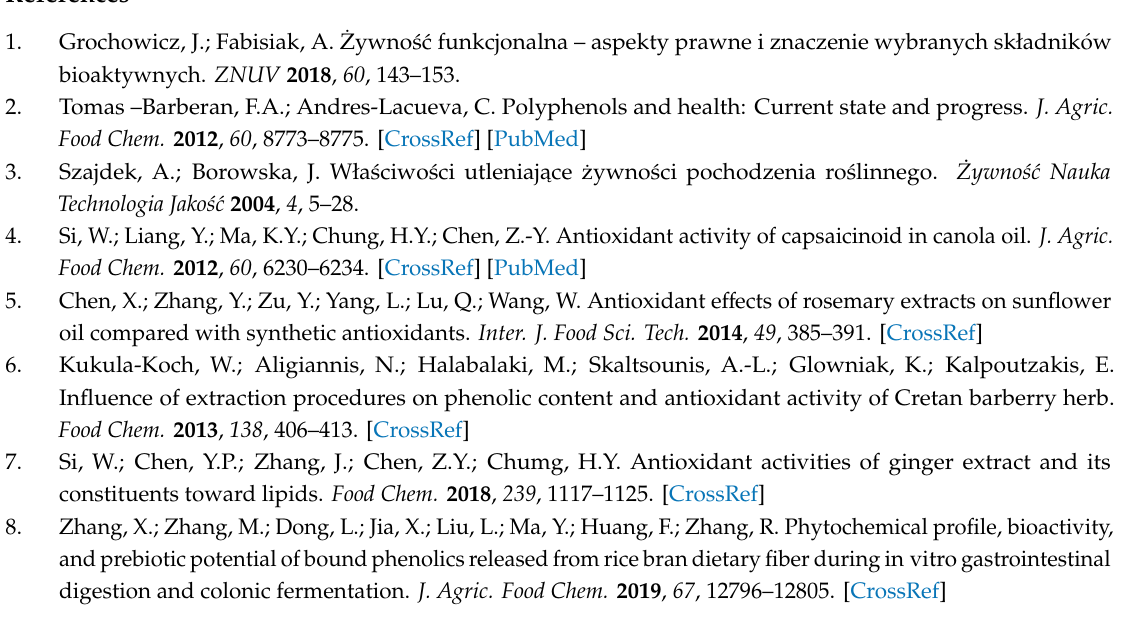
Supplementary Materials: Figure S1: Thye dose-response curves of biological activity of tested